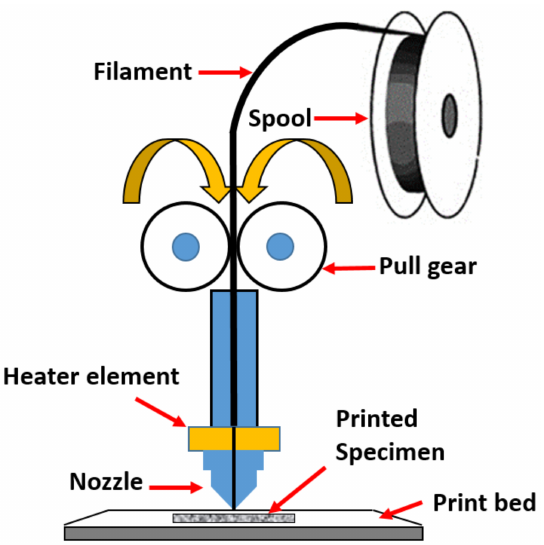
Figure 1. Schematic of a FDM 3D